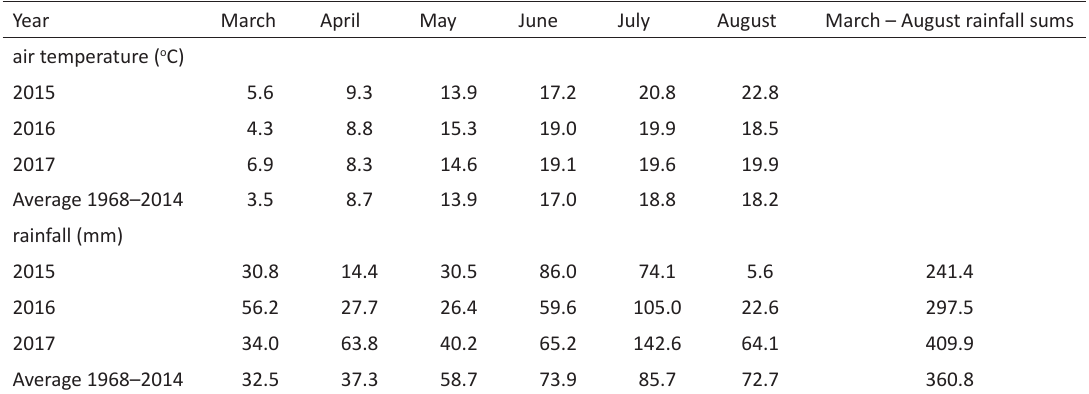
Table 3. Weather data for growing season of triticale-lupin mixture obtained from Agro- and Hydrometeorology Observatory in Agricultural Experiment Station